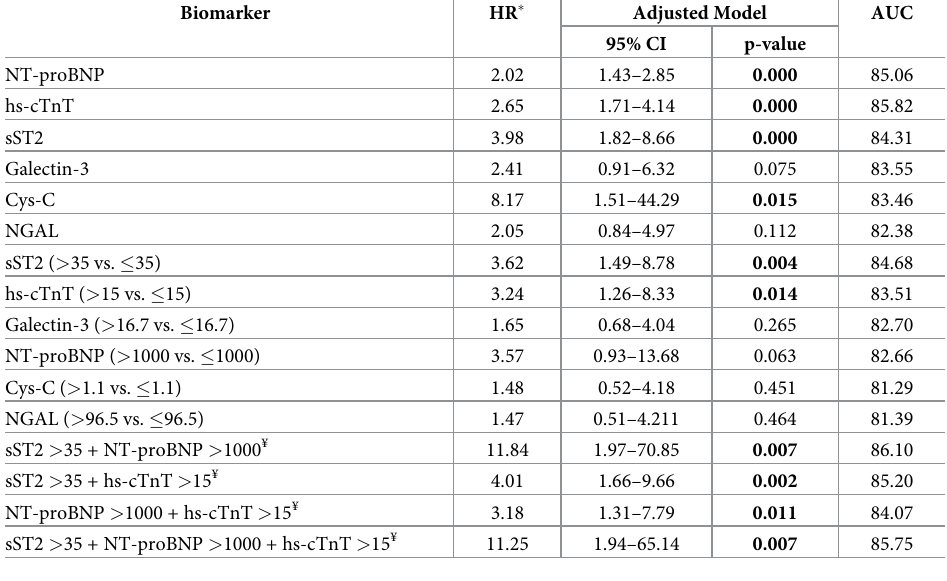
Table 2. Prognostic value of the log-transformed biomarker levels in a continuous manner and using cut-off points for the composite outcome in patients with CCM (n =